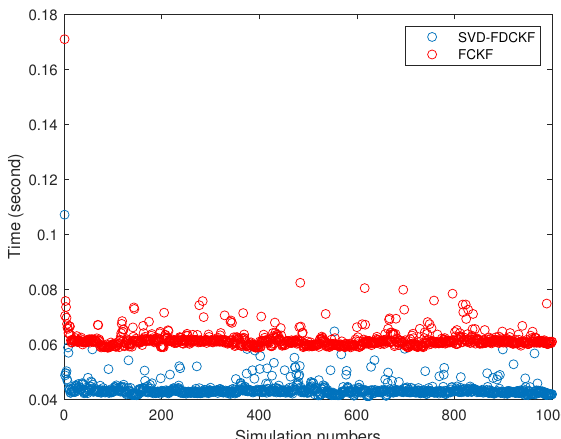
Figure 4. The simulation time in 1000 times Monte Carlo by the SVD-FDCKF and FCKF.